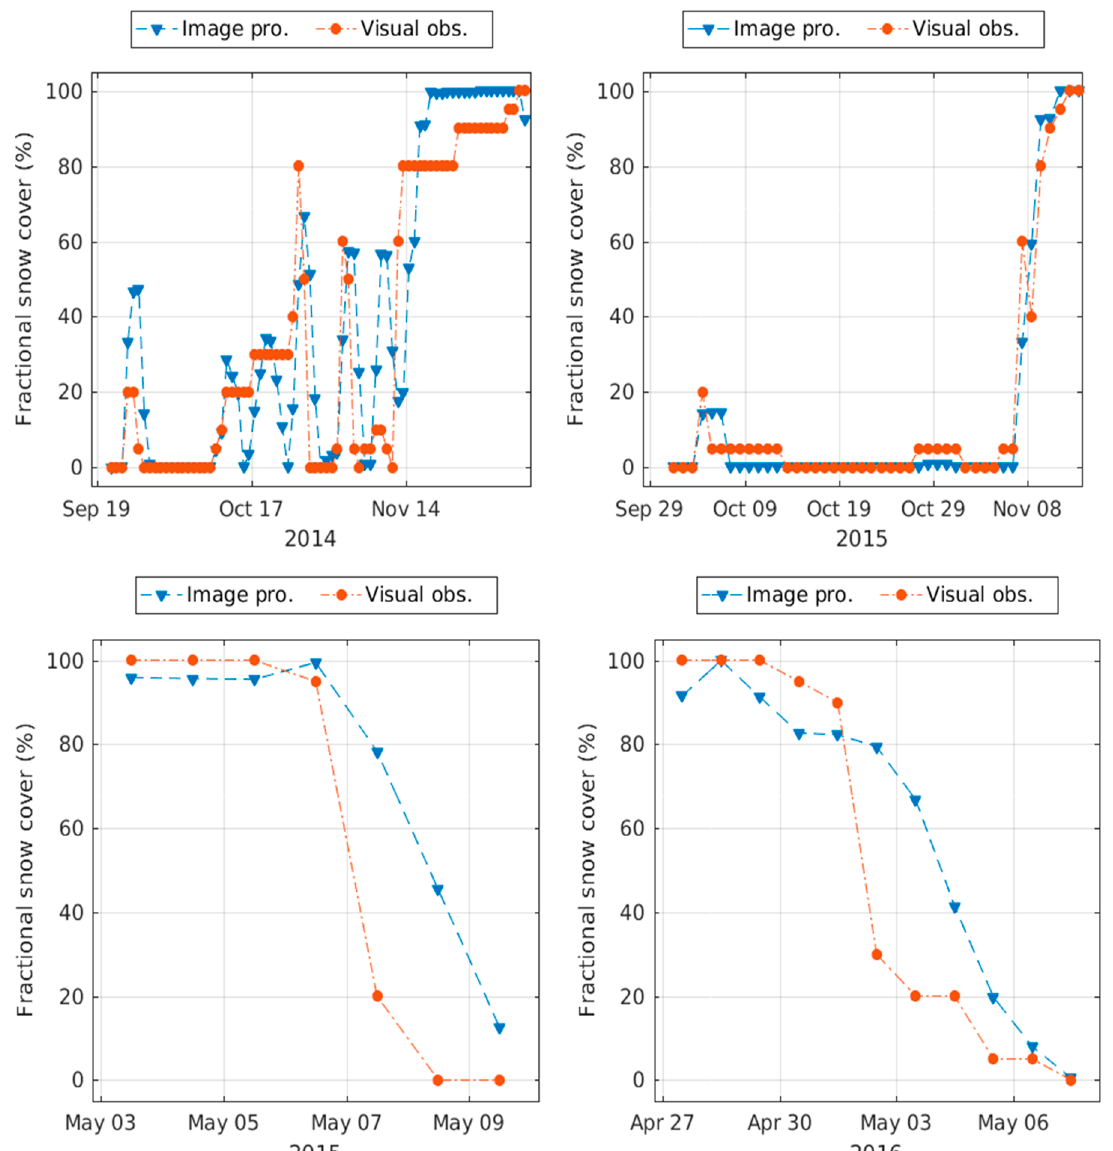
Figure 10. Sodankylä wetland camera early season ( top ) and melting season ( bottom ) comparison of image processing results and visual observations.